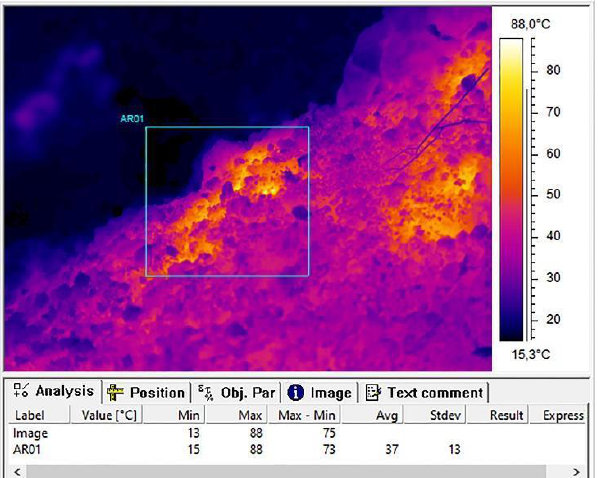
Figure 2. FLIR “ThermaCAM Researcher Pro 2.10” software [34]. Example of a thermal image and of the extraction of some image parameters. This image was taken from the Pizzone area (Ischia), indicated as “Piz” in Figure 1.